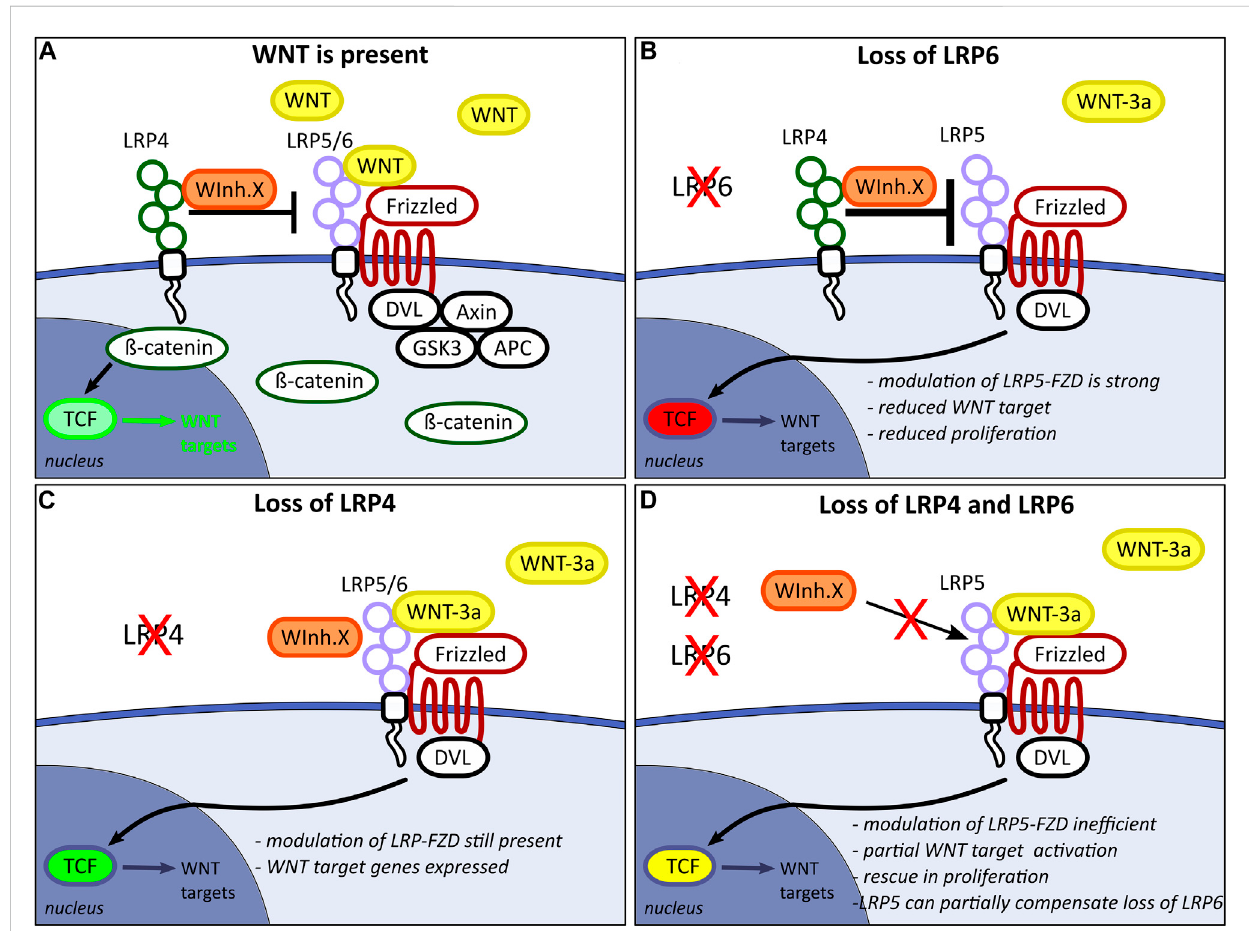
FIGURE 8 HypotheticalmodelforWNTpathwaymodulationbytheLRP-Frizzled(FZD)complexinthedevelopingforebrain. (A) LRP4actsasaninhibitoronthe LRP5/6-FZD complex and limits LRP5/6 binding capacity for WNT ligands, which consequently modulates WNT downstream target expression. LRP4 might present a WNT inhibitor X (WInh.X) to the LRP5/6-FZD complex. Model adapted from Ahn and colleagues (Ahn et al., 2013). (B) The loss of LRP6 function in the presence of WNT pathway inhibition by LRP4 leads to insuf fi cient compensation by LRP5. This results in impaired binding of WNT3atotheLRP5-FZDcomplex,therebyinducingasigni fi cantreductionintheexpressionofWNTtargetgenes. (C) InabsenceofLRP4,WNTinhibitorX can still bind to the LRP-FZD receptor complex. Slightly increased WNT/ß-catenin activity does not lead to signi fi cantly altered WNT downstream gene expression. (D) In Lrp4 − / − ; Lrp6 − / − doublemutants,LRP4 cannolongerpresentWNTinhibitorXtotheLRP-FZDcomplex.BindingofWInh.X toLRP5istoo weak to have an inhibiting effect on the WNT/ß-catenin pathway activation. LRP5 can partially compensate for loss of LRP6 only in the absence of the WNT pathway inhibitor